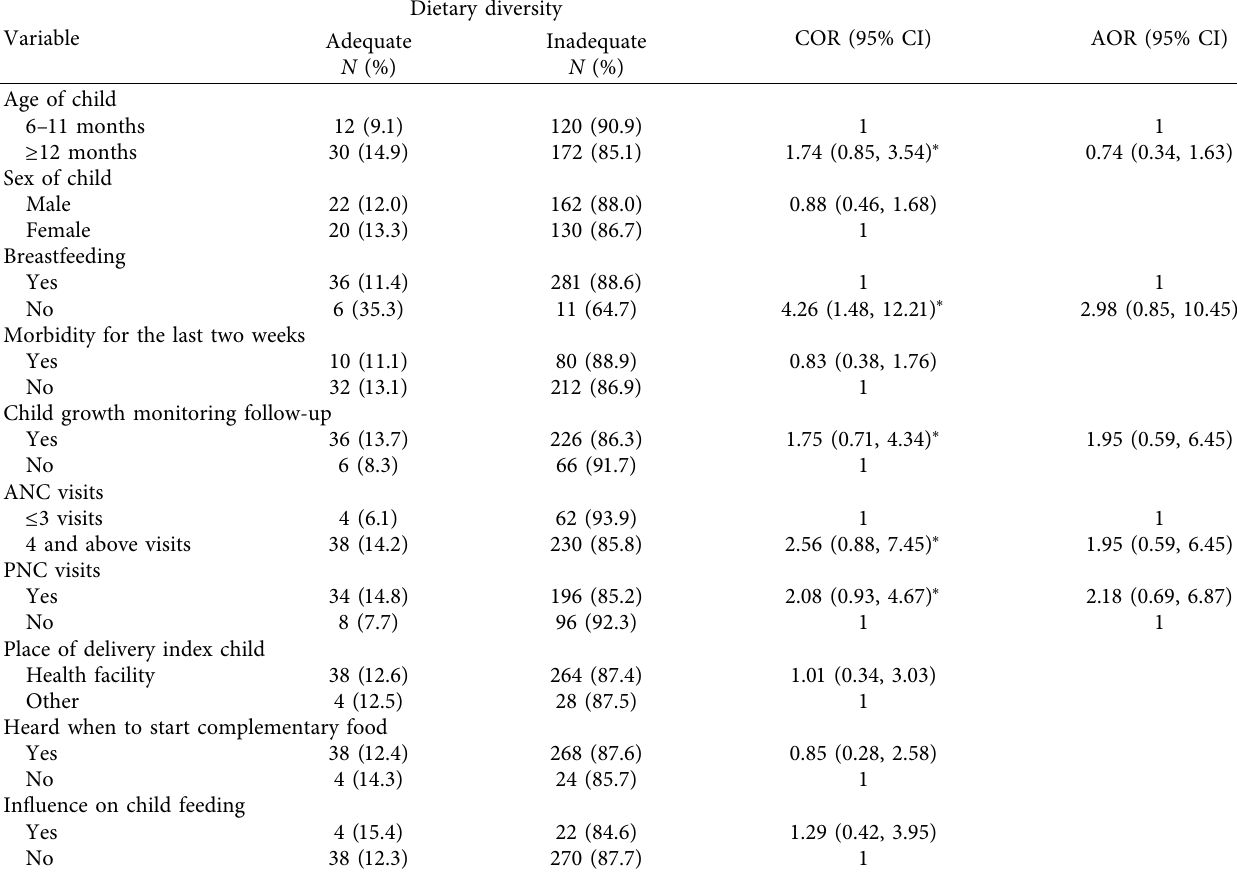
Table 5: The result of bivariate and multivariable logistic regression to assess the association of adequate dietary diversity feeding